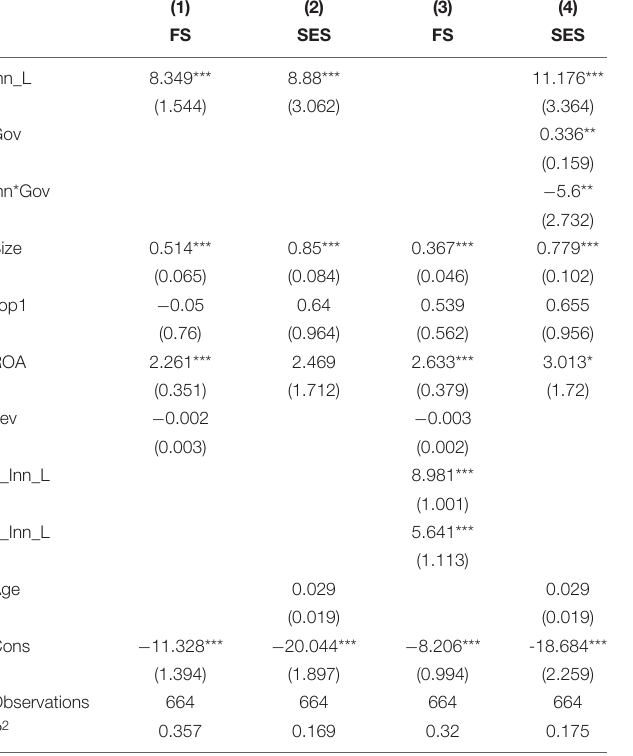
TABLE 7 | Results of robustness test.